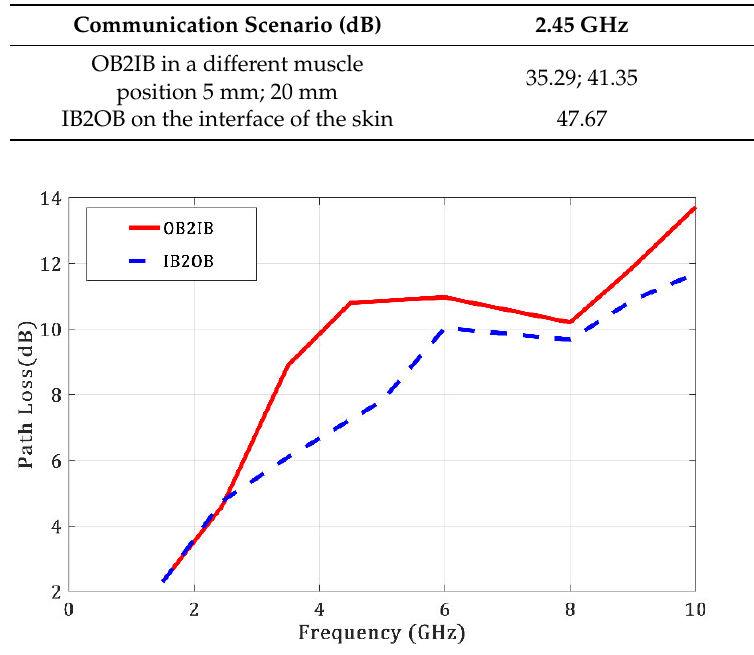
Figure 9. Path loss for different communication scenarios.